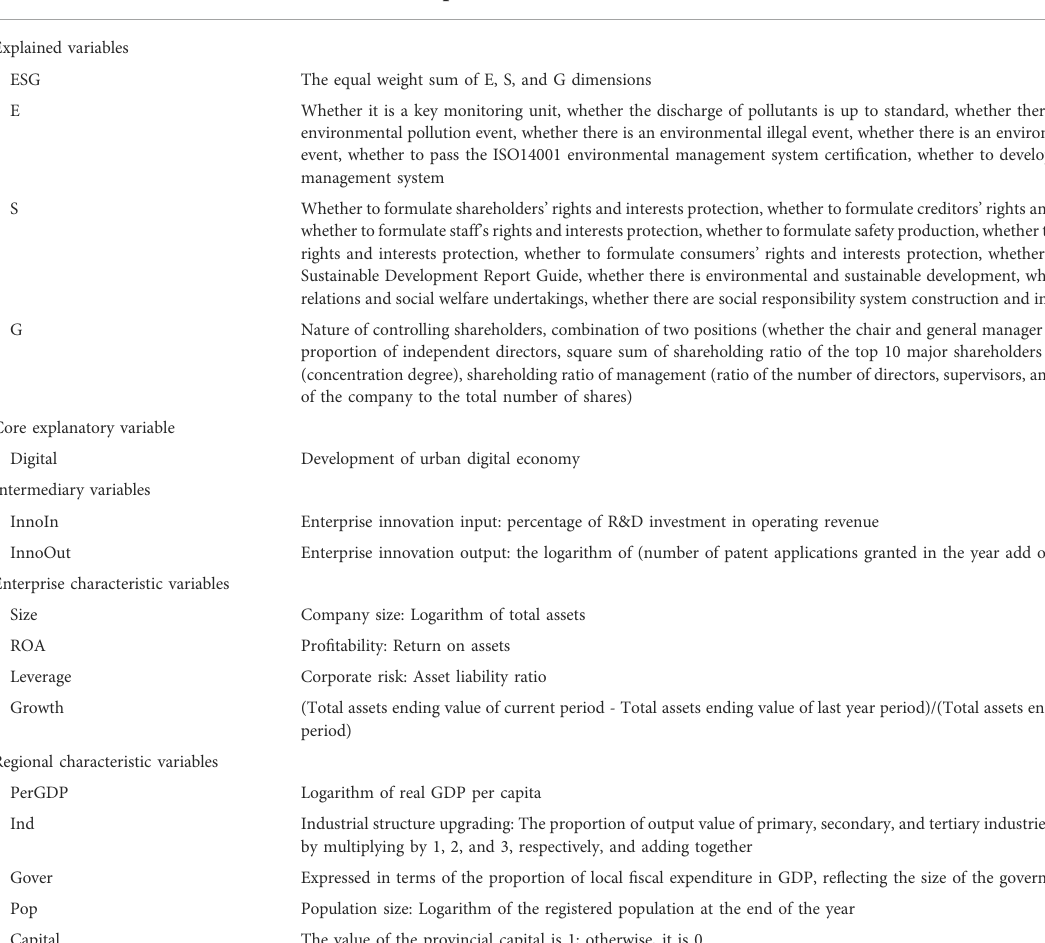
TABLE 1 Variable de fi